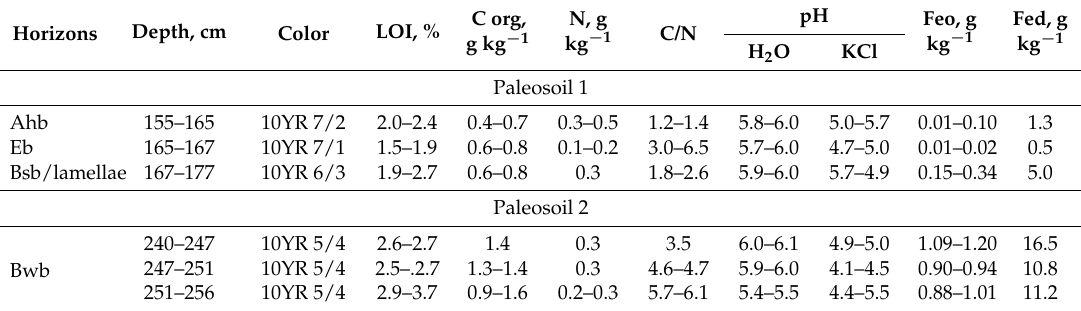
Table 2. Chemical properties of buried soils.